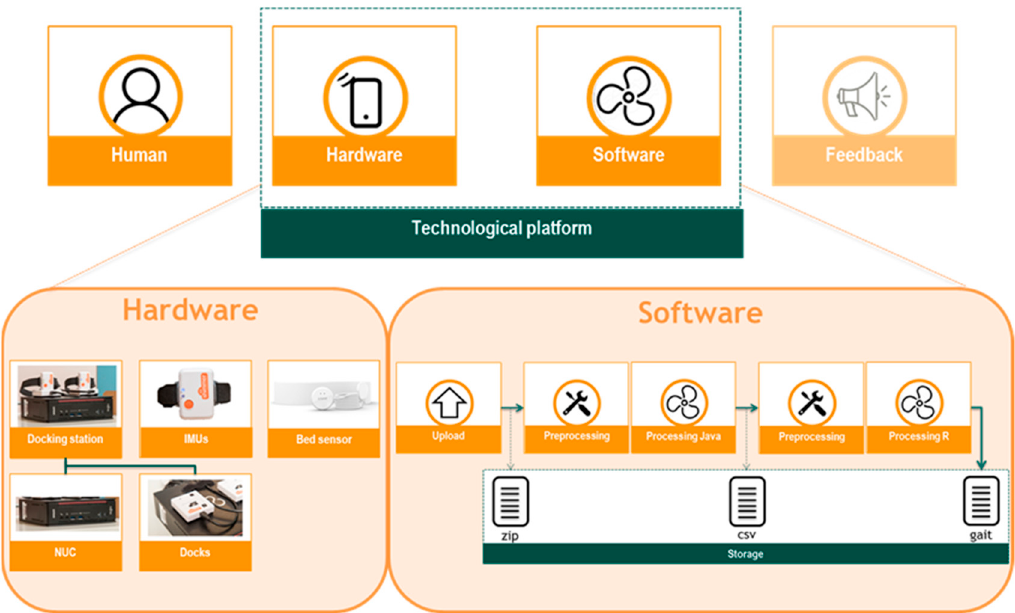
Figure 1. Graphical representation of the sensor-based technological platform consisting of a hardware (docking station consisting of Next Unit of Computing (NUC) and two docks, Inertial Measurement Units (IMUs), and a bed sensor) and software (upload, preprocessing, processing, and storage)